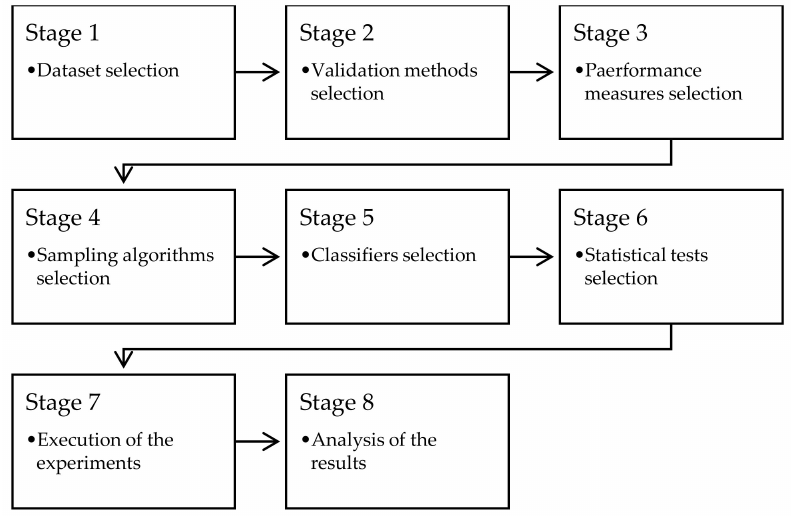
Figure 1. Stages of the proposed